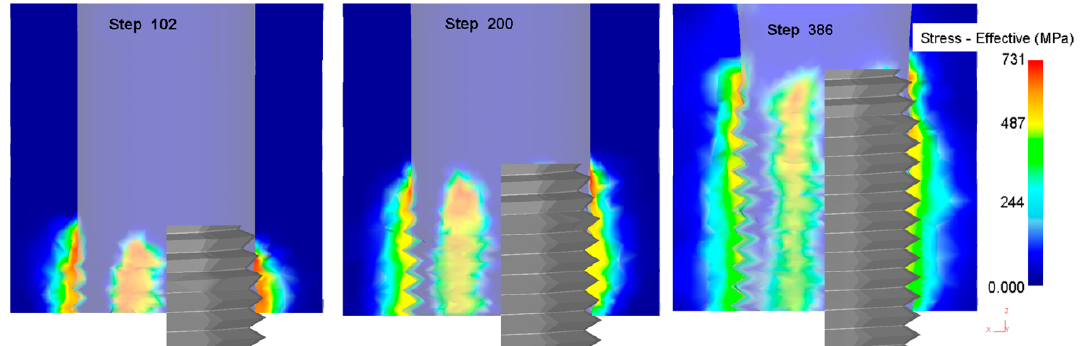
Figure 4. Equivalent stress nephogram of different steps.